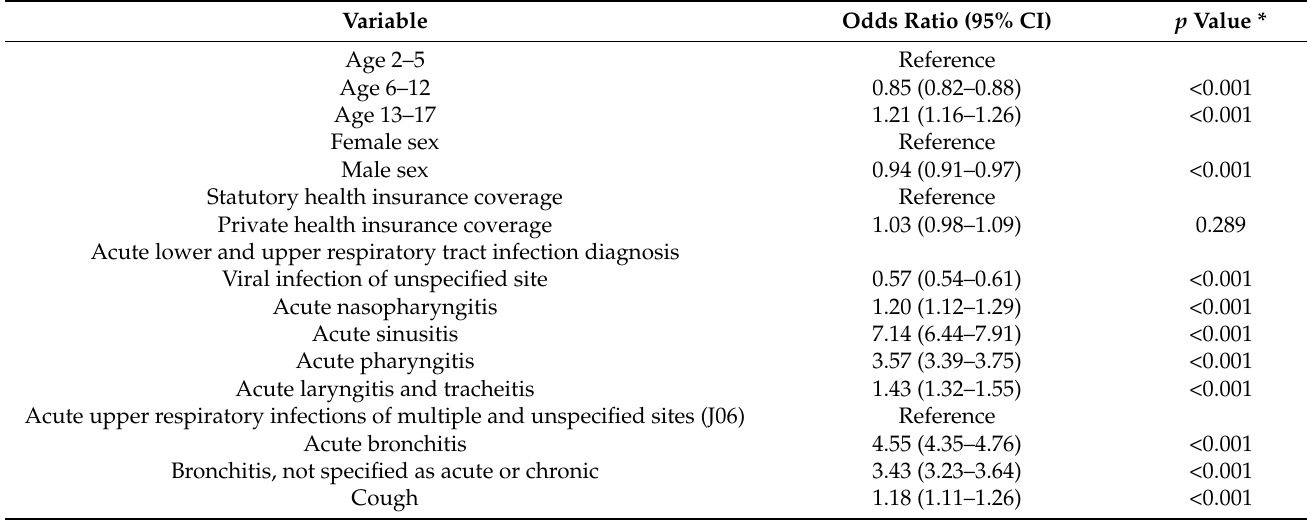
Table 4. Variables associated with an antibiotic prescription in patients diagnosed with an acute lower and upper respiratory tract infection diagnosis in pediatric